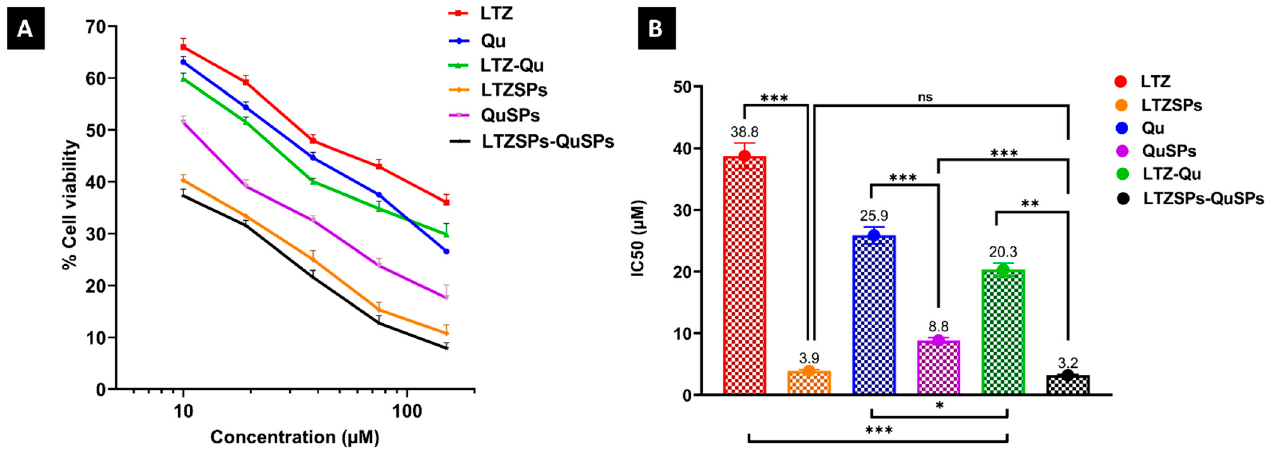
Figure 5. Cytotoxicity assessment using MTT assay against MCF-7 cell line. ( A ) Dose–response curves of MCF-7 cells to treatment with LTZ, Qu, and their combination and also LTZSPs, QuSPs, and their combination using indicated concentration range using an MTT assay after 48 h of treatment. ( B ) The mean IC 50 of LTZ, Qu, and their combination and also LTZ-Qu, LTZSPs, and their combination against MCF-7 cells. Data are expressed as mean ± SD ( n = 3). *** p < 0.001, ** p < 0.01, * p < 0.05. Abbreviations: LTZ; letrozole, Qu; quercetin, LTZSPs; letrozole-loaded spanlastics, QuSPs; quercetin-loaded spanlastics, ns; not significant.